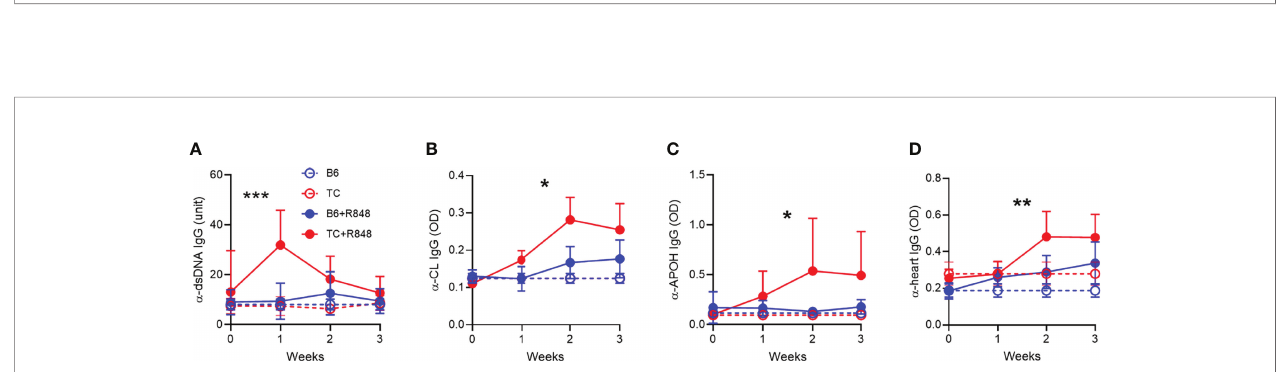
FIGURE 5 | TLR7 activation induced the production of anti-cardiovascular autoantibodies in TC mice. Serum IgG in control (n = 3) and R848-treated B6 and TC mice (n = 11 - 16) directed against dsDNA (A) , CL (B) , APOH (C) and heart tissue (D) . Statistics compare treated TC and B6 mice with t test between week 1 values (A) , and 2-way ANOVA for all values up to week 3 (B – D) *: P < 0.05, **: P < 0.01, ***: P <